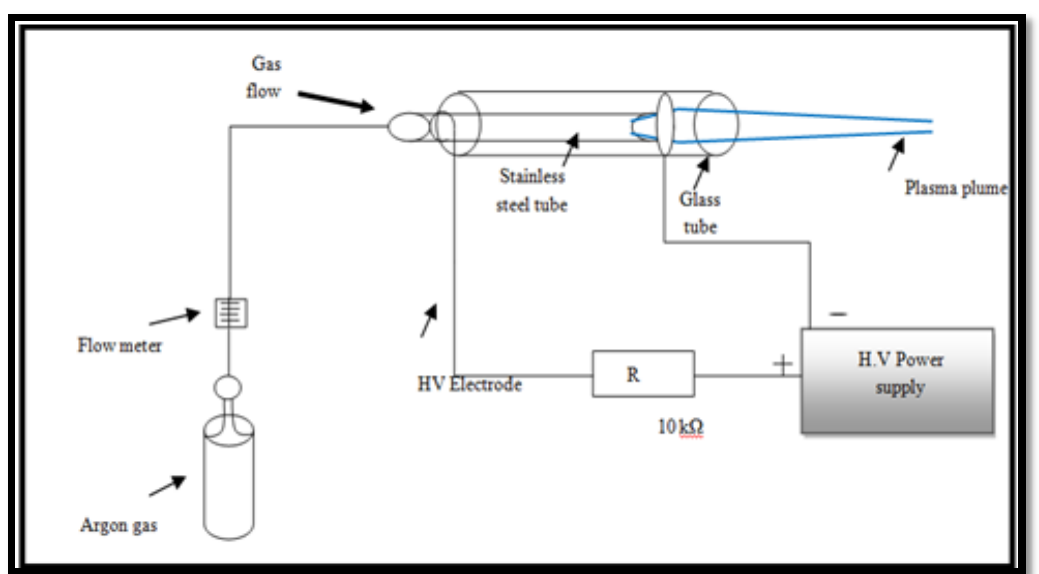
Fig. 2: Schematic diagram of plasma needle